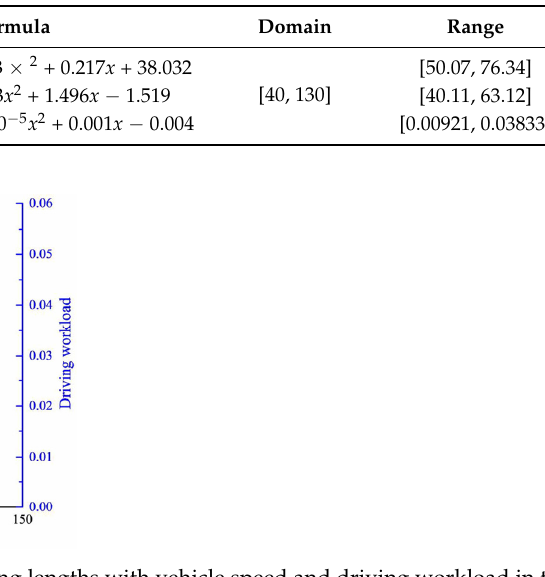
Table 7. Fitting results of different opening lengths with vehicle speed and driving workload in the work zone.